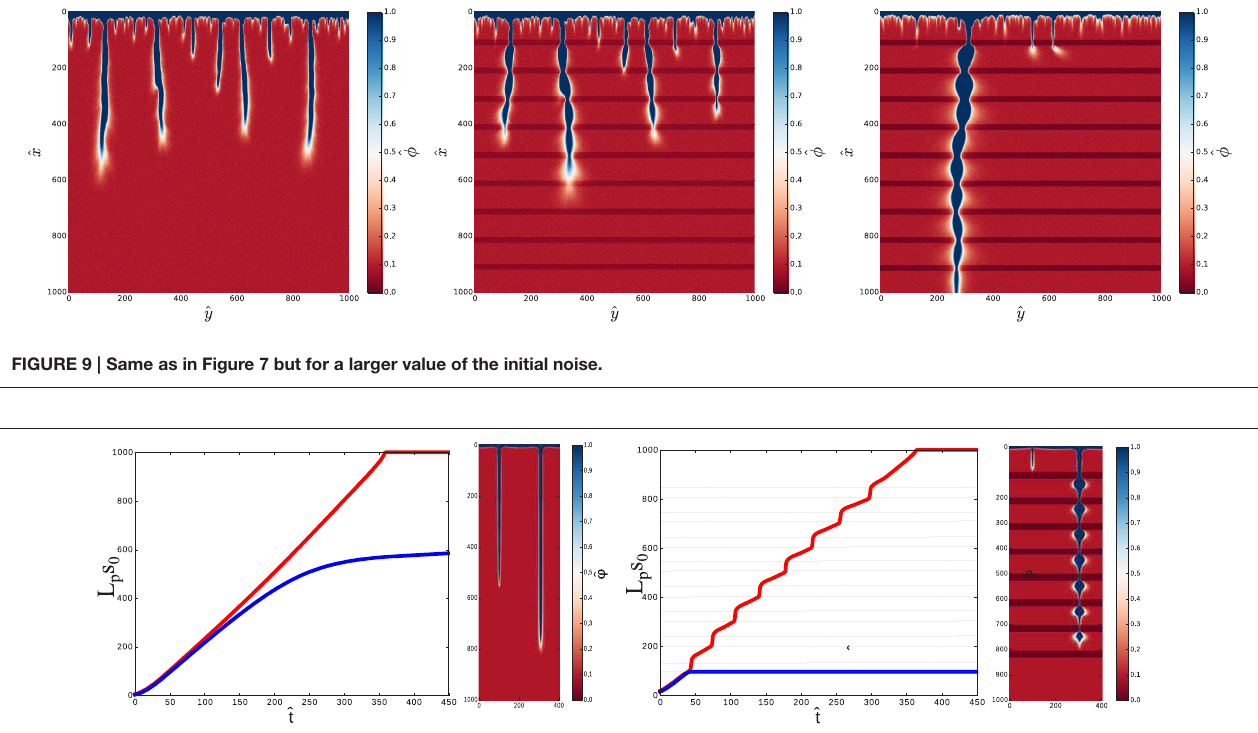
FIGURE 10 | The positions of the pipe tip vs. time in a two-pipe system in non-stratified (left) and stratified case. Red color marks the faster, winning pipe, and blue - the slower one. The 2d contour-plots show the corresponding dissolution